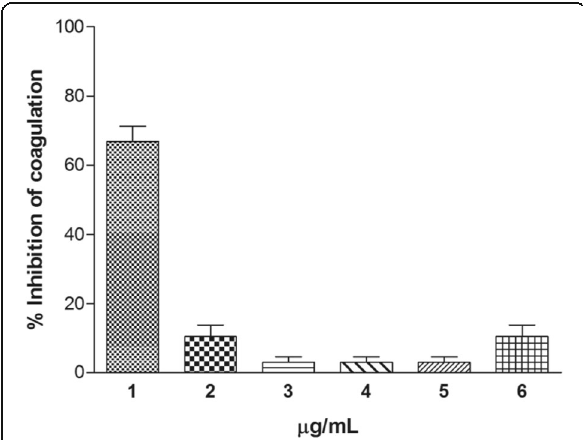
Fig. 5 Effect of cnidarian extracts on coagulation.(1) C. gigantea (body-wall), (2) C. gigantea (total), (3) M. alcicornis, (4) S. helianthus, (5) P. homomalla , (6) B. annulata, 200 μ g/mL of the extract were pre-incubated with fibrinogen; clotting was then started by the addition of thrombin and monitored at A 405 nm. Results are reported as mean % ± S. D (n = 3)